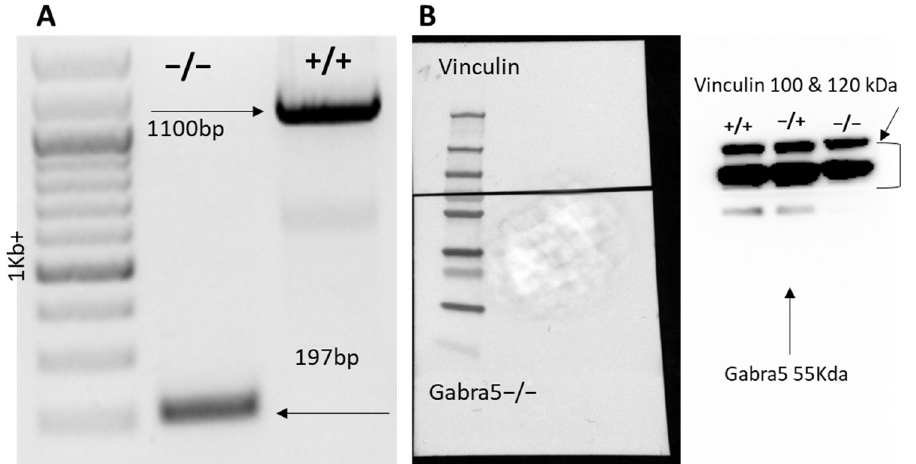
Figure 1. Model validation. ( A ) representative genotyping gel where the KO has a band of 197 bp and the WT 1100 bp. ( B ) western blot of WT, heterozygote and Gabra5 − / − hippocampi. Colorimetric picture on the left and antibody bound protein exposed on the right. The α 5 subunit protein was detected at 55 kDa in WTs and in the heterozygote, it was not observed in the homozygote. The loading control vinculin was detected at 100 and 120 kDa and seen in all samples.